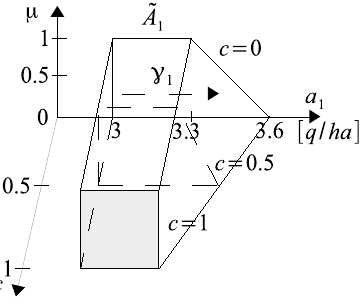
Figure 33. Knowledge about the value of the a 1 [ q/ha ] coefficient of yield increase caused by the increase in fertilization from d = 0 to d = 1, presented in the form of T2FN.